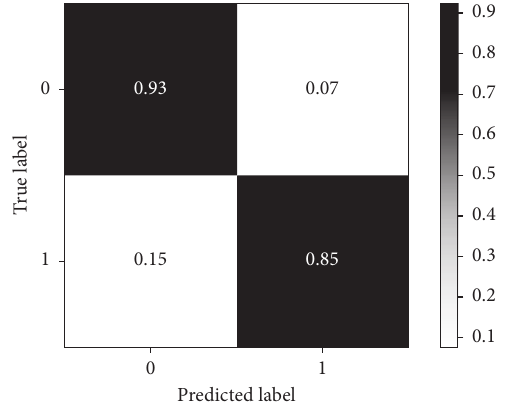
Figure 4: Confusion matrix for testing data using SVM